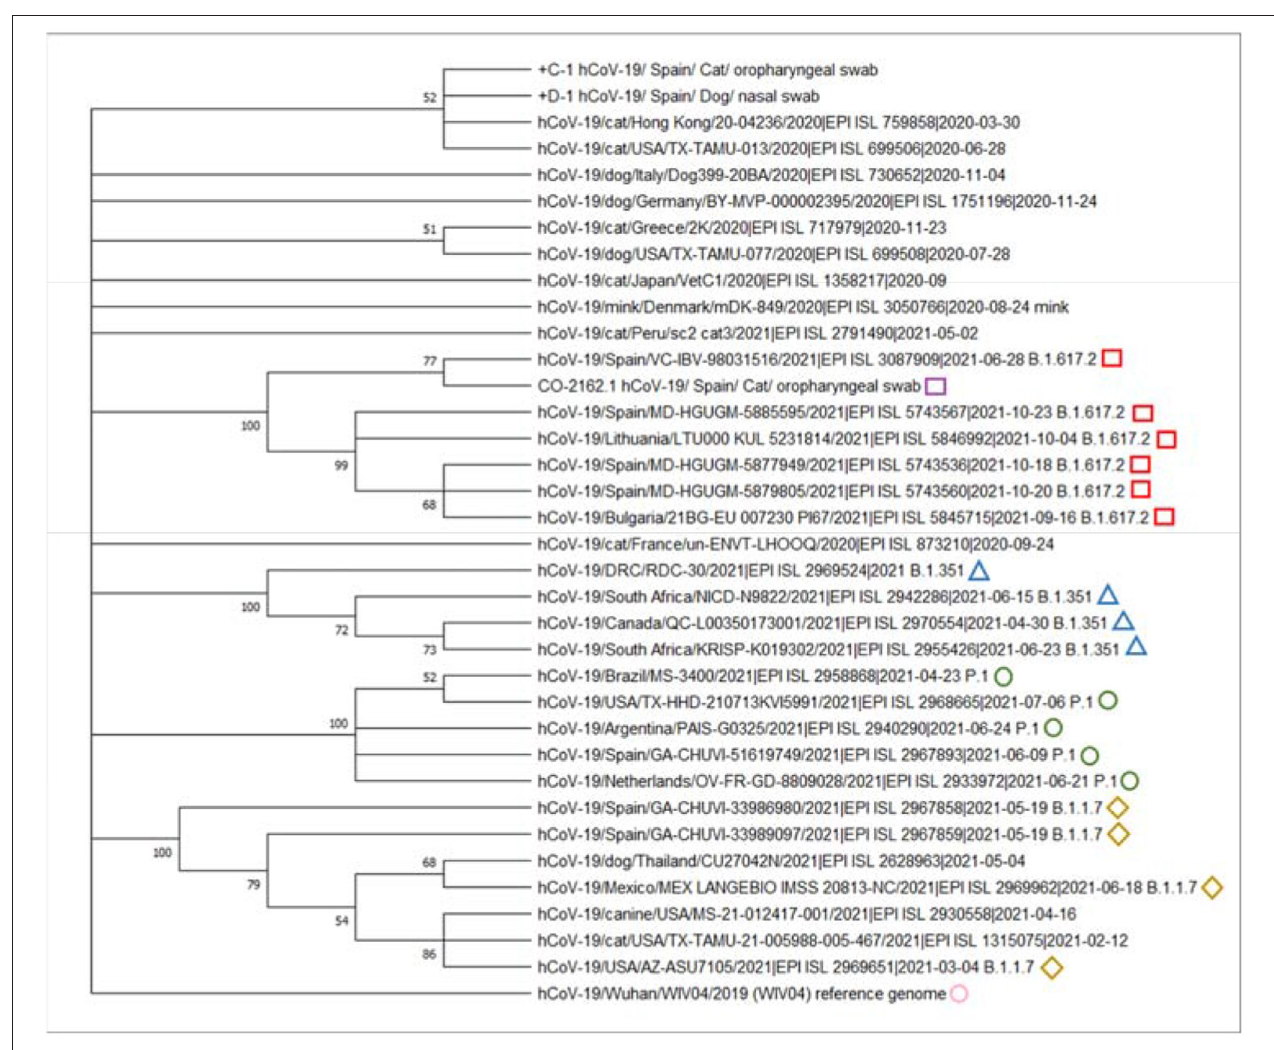
FIGURE 1 | Phylogenetic analysis of SARS-CoV-2 (Severe Acute Respiratory Syndrome Coronavirus 2) indicated that the whole-genome sequence from this study (purple square) was similar and clustered with the SARS-CoV-2 B.1.617.2 (Delta) sublineage genomes from included in the alignment. Green squares indicate the variant of concern B.1.1.7; red diamonds indicate the variant of concern P.1; blue triangles indicate the variant of concern B.1.617.2; yellow circles indicate the variant of concern B.1351. Pink circle indicates the reference SARS-CoV-2 (WIV04) genome from Wuhan. We appreciatively acknowledge the different laboratories